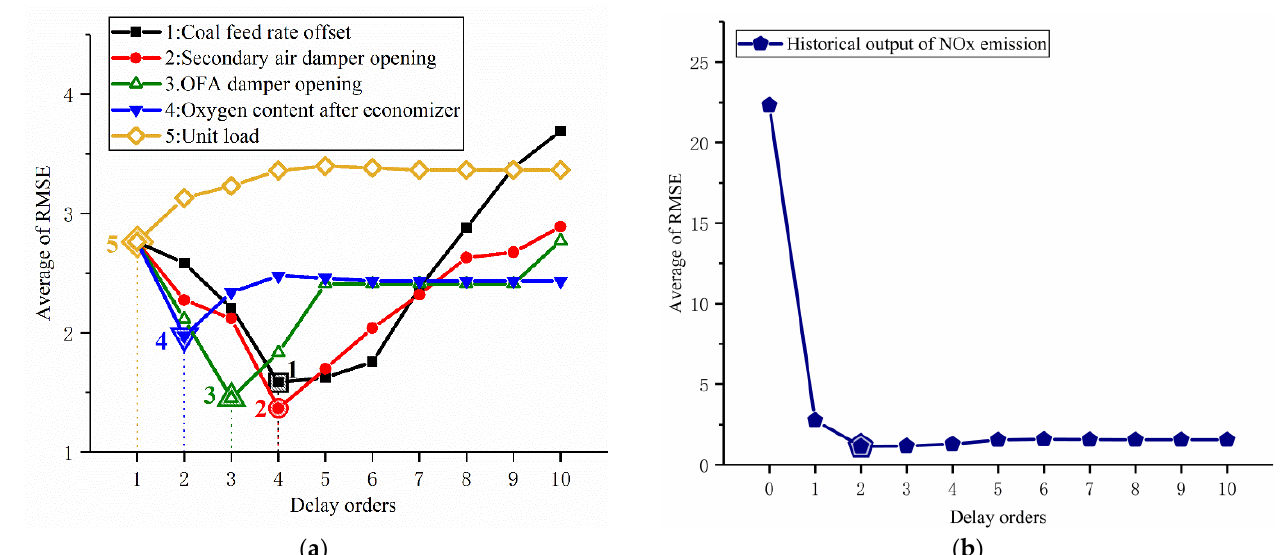
Figure 5. Incremental analysis of the delay orders in the NOx model. ( a ) Analysis result of n coal , n sec , n ofa , n o2 , n load ; ( b ) analysis result of the historical output n NOx .